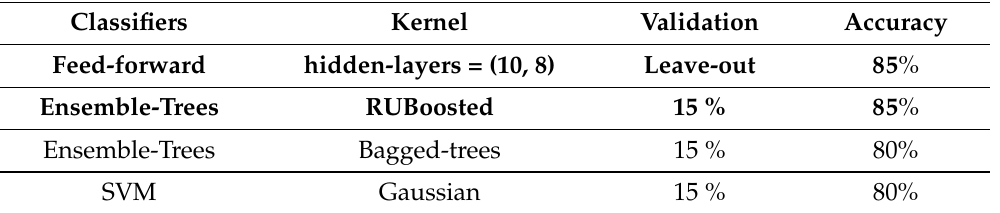
Table 8. The accuracy of classification of different classifiers of the systolic-based sub-experiment (136 subjects).